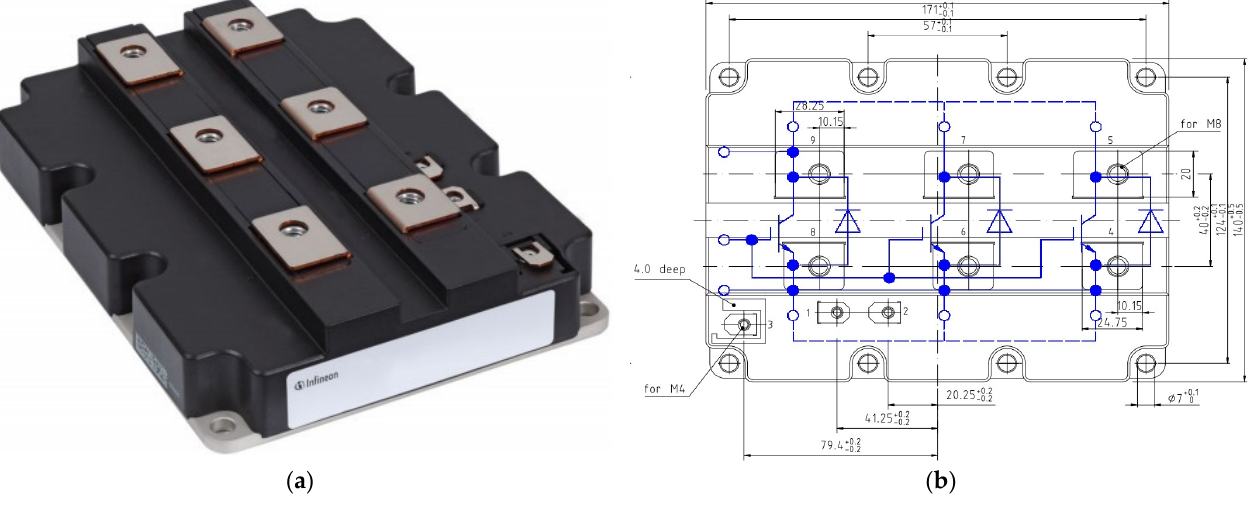
Figure 5. Testing platform designed for test section installation.